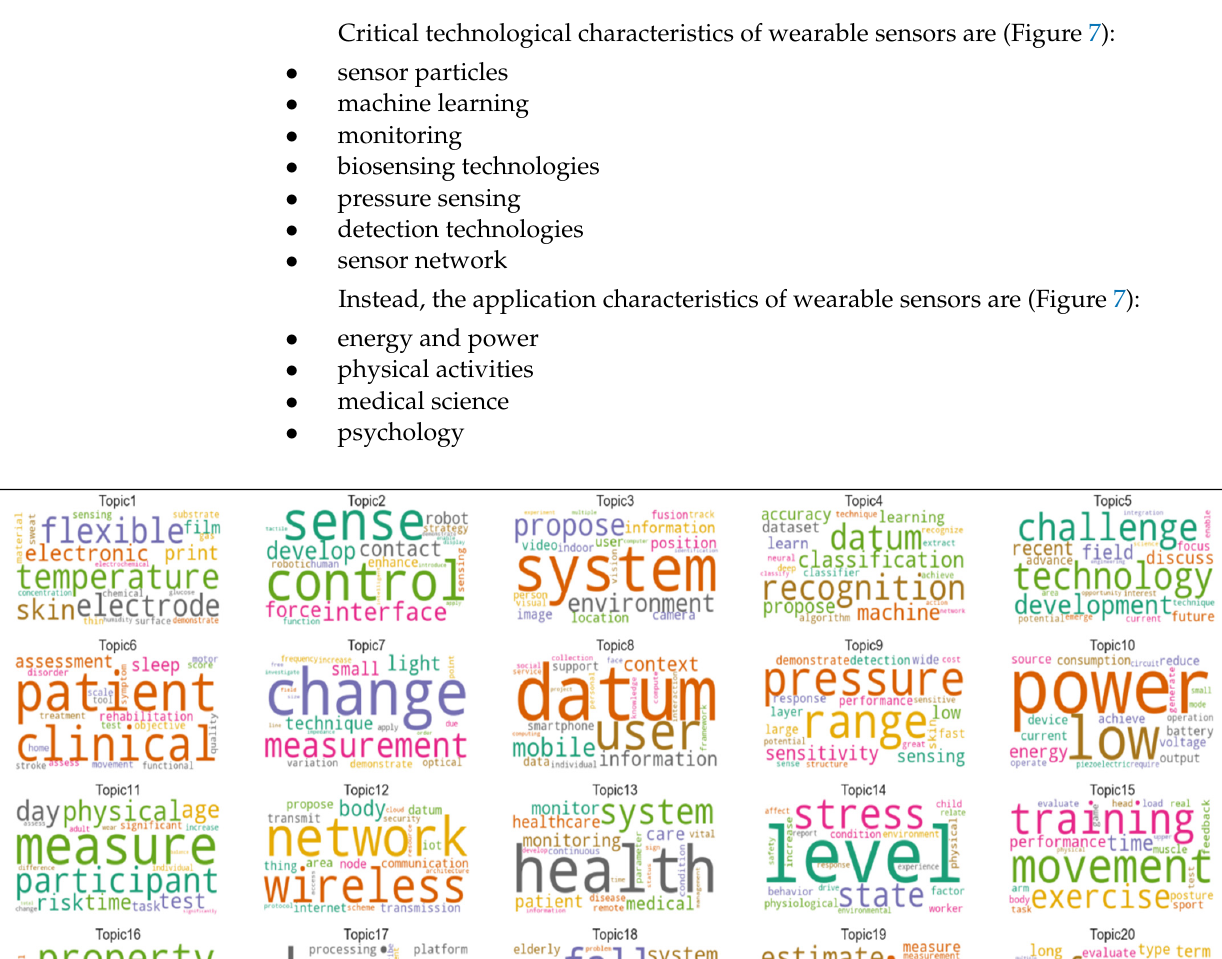
Number of Topics